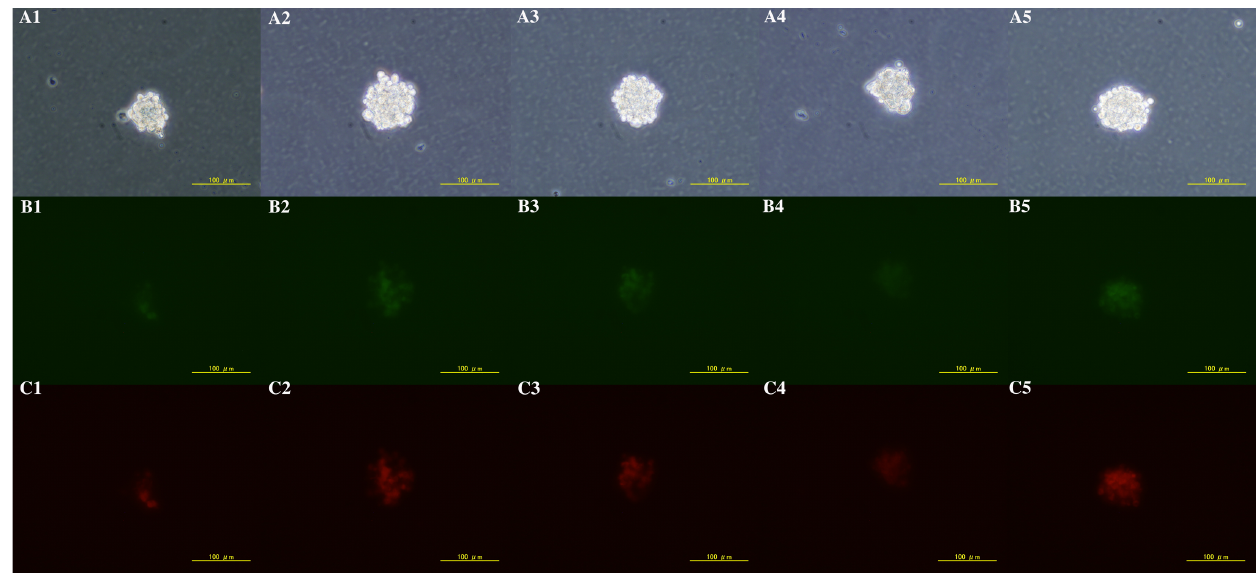
Figure 1. Examples of cell aggregates generated from oct-gfp transgenic spleen by low pH treatment. ( A ) Phase contrast views of typical five cell aggregates, ( B ) their green fluorescence and ( C ) their red fluorescence.